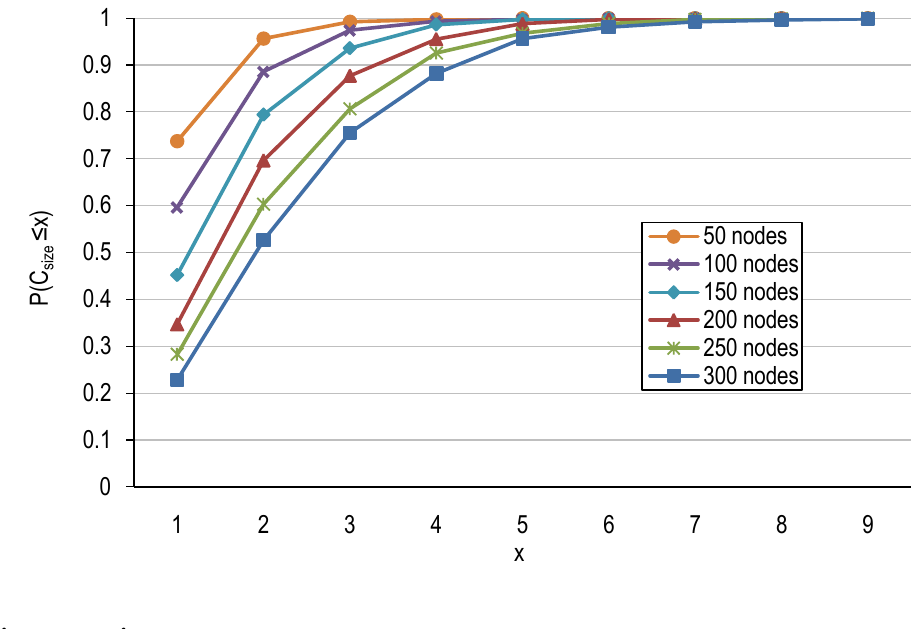
Figure 7. The cluster size cumulative distribution function as a function of node densities (γ =